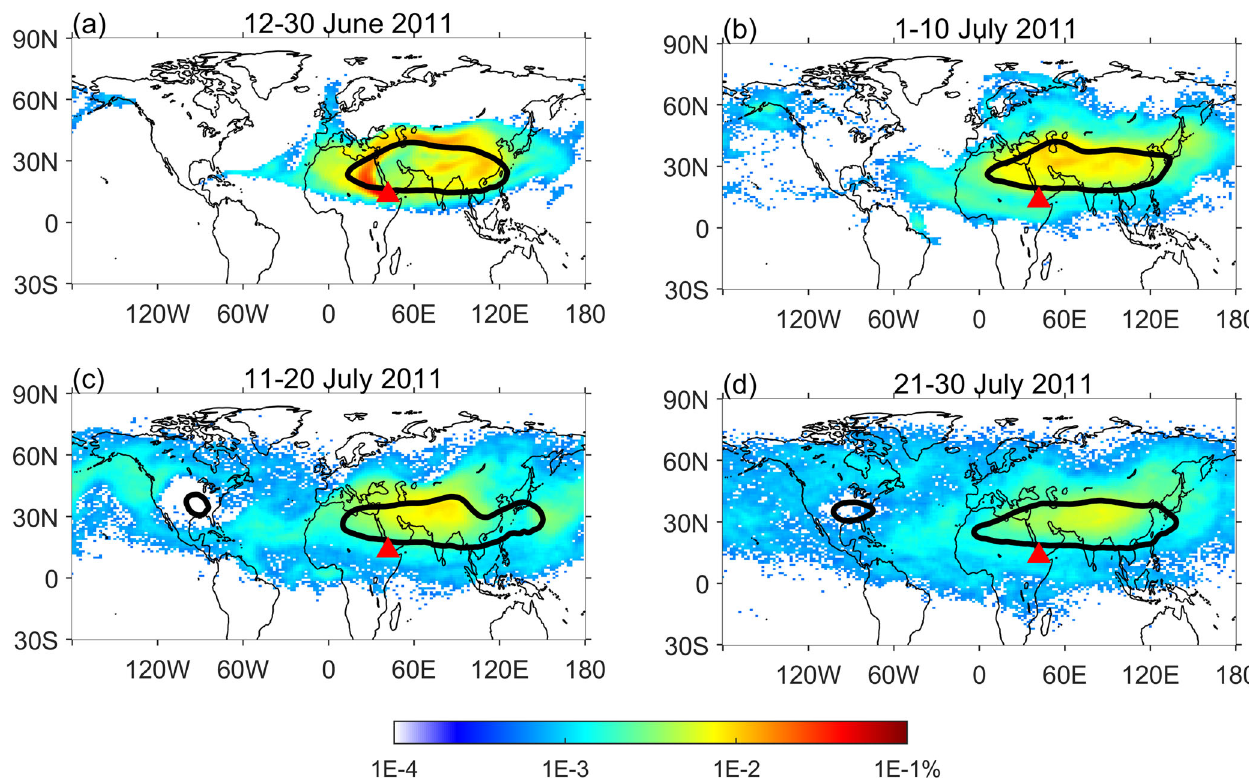
Fig. 4 Percentage (%) of air parcels between isentropic surfaces of 360 – 420 K from MPTRAC simulations for the Nabro eruption. The percentage of air parcels are shown during a 12 – 30 June 2011, b 1 – 10 July 2011, c 11 – 20 July 2011, and d 21 – 30 July 2011. The bin size is 2° × 1°. The boundary of the ASMA is marked by the 14,320 m geopotential height at the 150 hPa pressure level (thick black contours). The fi lled red triangles indicate the Nabro